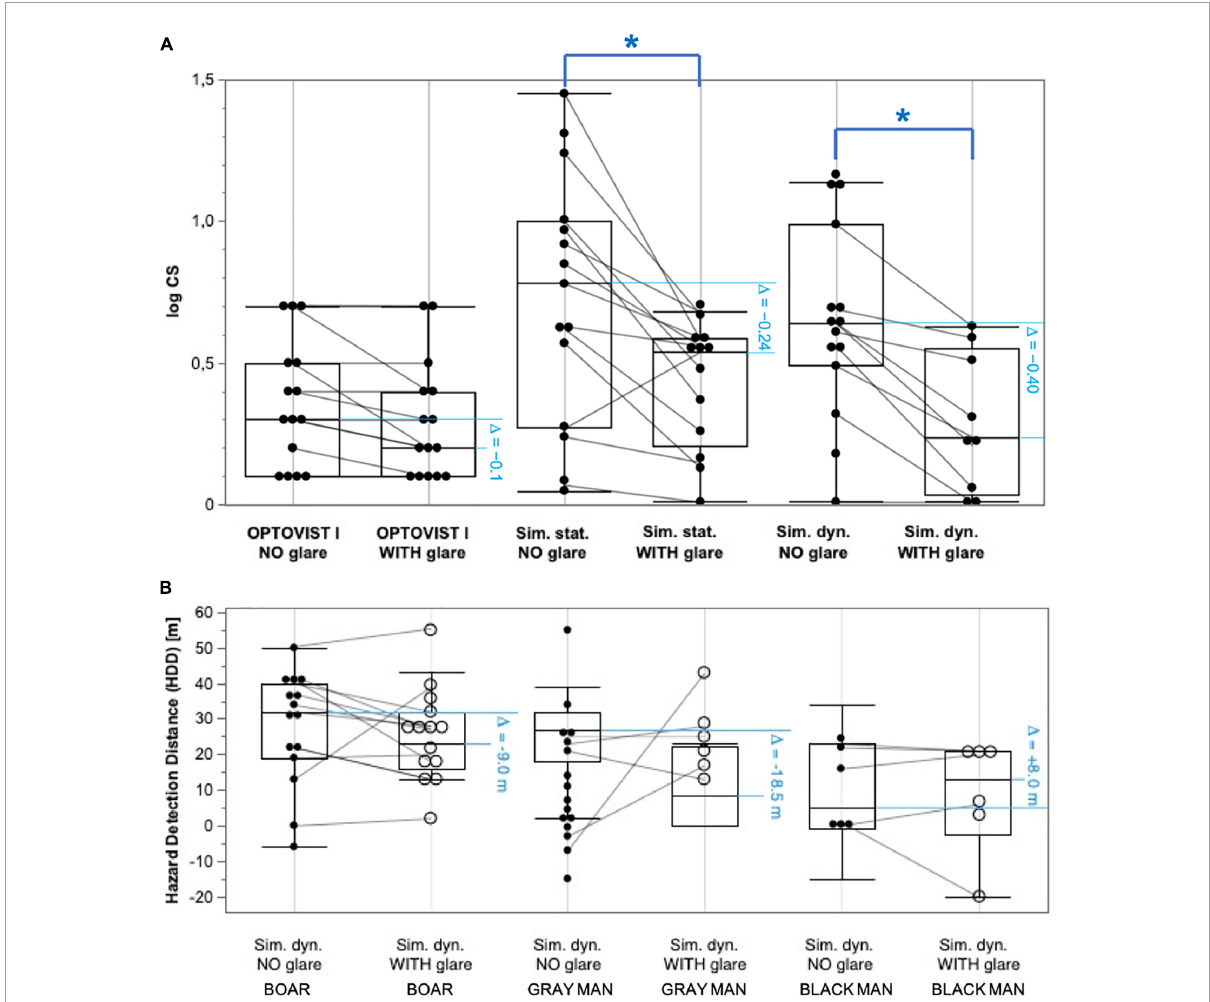
FIGURE5 Pairwise comparisons ( without vs. with glare) of log CS frequency distributions and hazard recognition distance (HRD) distributions, each shown as box and whisker plots: lower and upper limits of the box indicate the position of the 25th and 75th percentile, respectively, and thus represent the interquartile range (IQR); the enclosed horizontal line within the box visualizes the median. The whiskers symbolize the 1.5-fold of the IQR; in addition, the individual results are shown as black dots (local overlaps of dots are possible). Gray lines connect the results of the respective test person. Asterisks (*) mark statistically significant differences between without and with glare conditions. (A) Clinical test : log CS, obtained with Optovist I ( without and with glare); Simulator test : static conditions, ADAPTIVE thresholding algorithm (BestPEST) without glare; static conditions, ADAPTIVE thresholding algorithm (BestPEST) with glare; dynamic conditions, ADAPTIVE thresholding algorithm (BestPEST) without glare; dynamic conditions, ADAPTIVE thresholding algorithm (BestPEST) with glare. (B) Simulator test ; hazard recognition distance (HRD): dynamic conditions, hazard recognition distance (m) BOAR (Weber contrast 87%), without glare ; dynamic conditions, hazard recognition distance (m) BOAR (Weber contrast 87%), with glare ; dynamic conditions, hazard recognition distance (m) GRAY MAN (Weber contrast 81%), without glare; dynamic conditions, hazard recognition distance (m) GRAY MAN (Weber contrast 81%), with glare; dynamic conditions, hazard recognition distance (m) BLACK MAN (Weber contrast 29%), without glare; dynamic conditions, hazard recognition distance (m) BLACK MAN (Weber contrast 29%), with glare. The horizontal blue pairs of lines indicate the amount of change between the conditions of glare exposition and the related baseline condition ( without